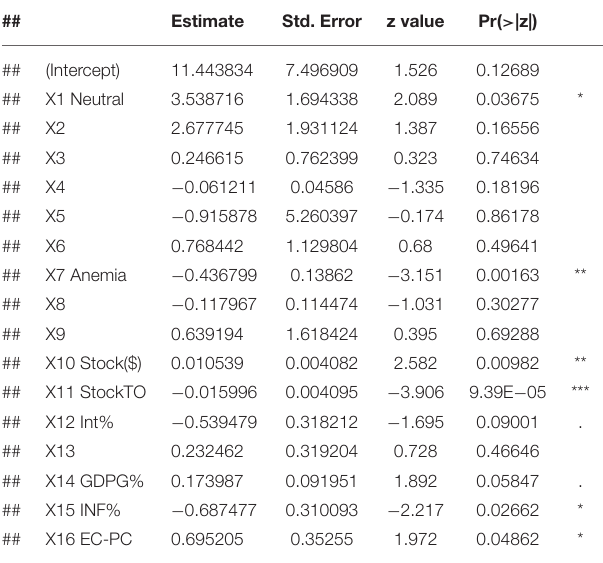
TABLE 6 | Logistic regression confusion matrix.